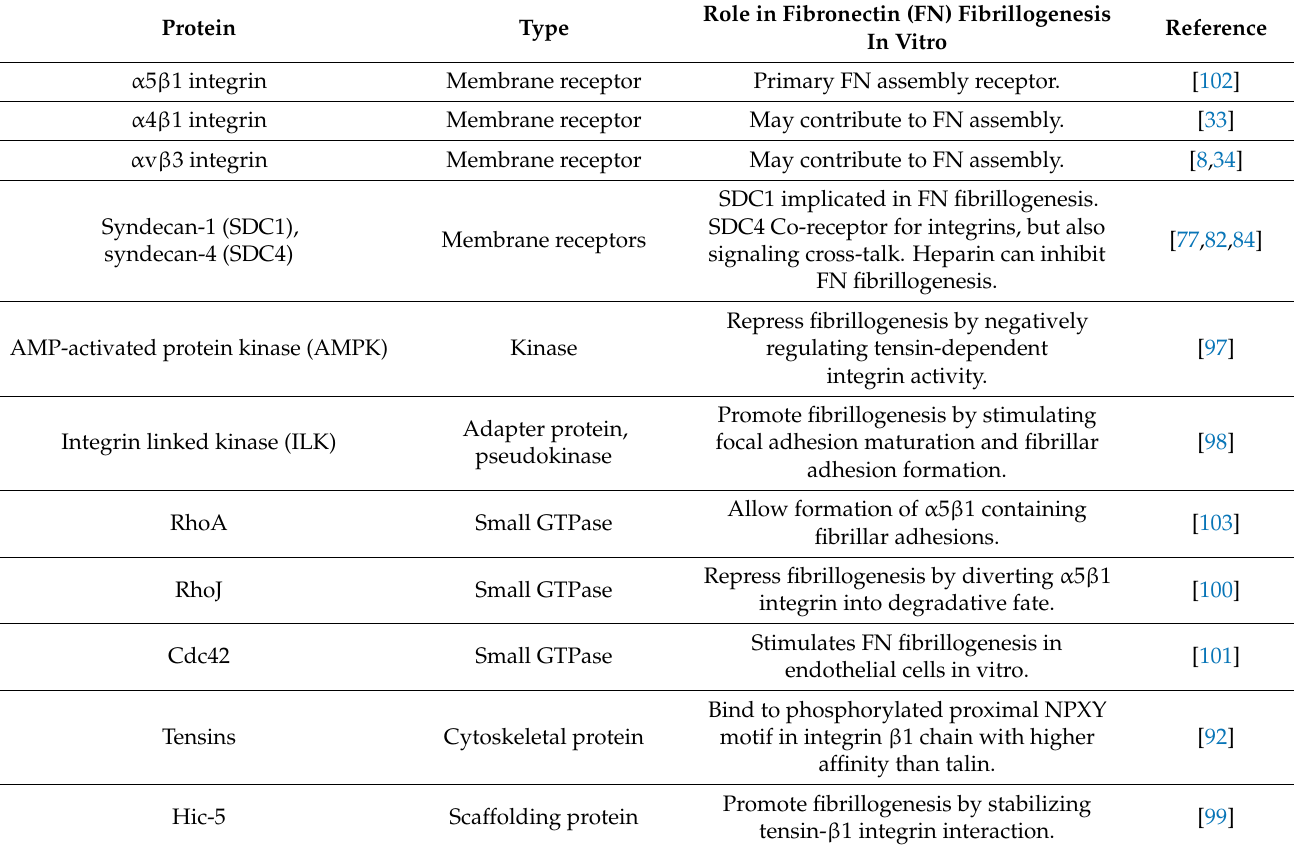
Table 1. Proteins Involved in Fibronectin Fibrillogenesis In